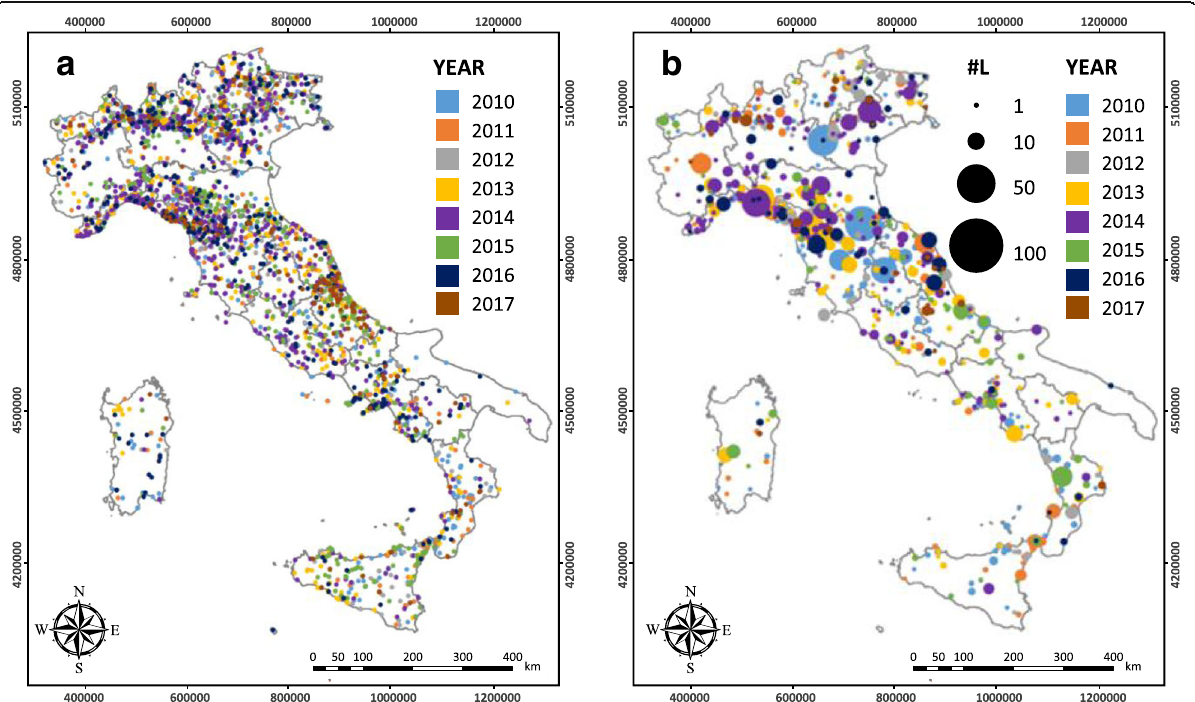
Fig. 2 The “ FraneItalia ” landslide catalog for the period 01/01/2010 – 31/12/2017: ( a ) SLE records; ( b ) ALE records [Legend: #L=Number of